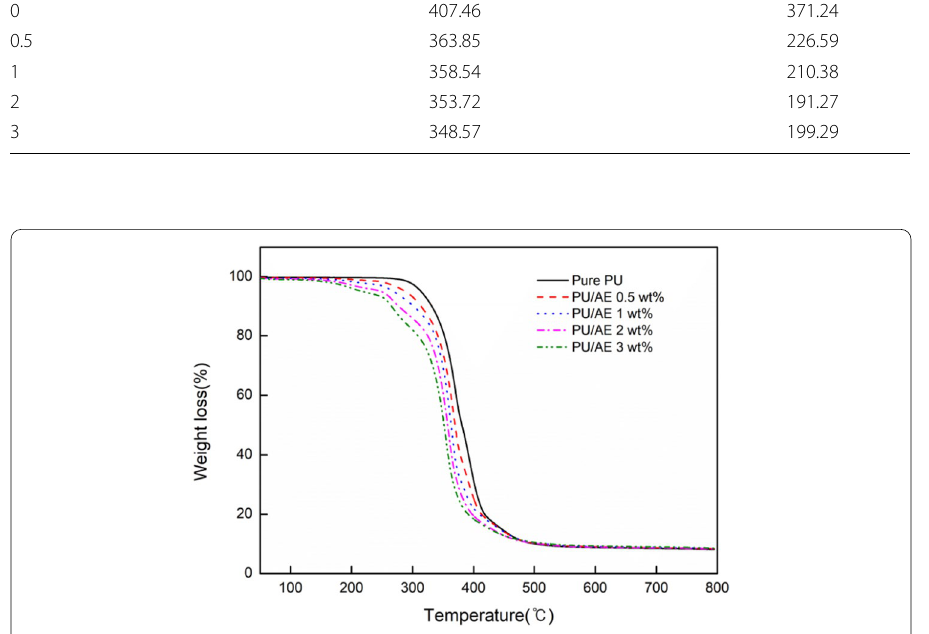
Fig. 7 TGA curves of PU/AE nanofibers for different AE concentrations. (PU solution concentration: 12%, Voltage: 20 kV and TCD:15